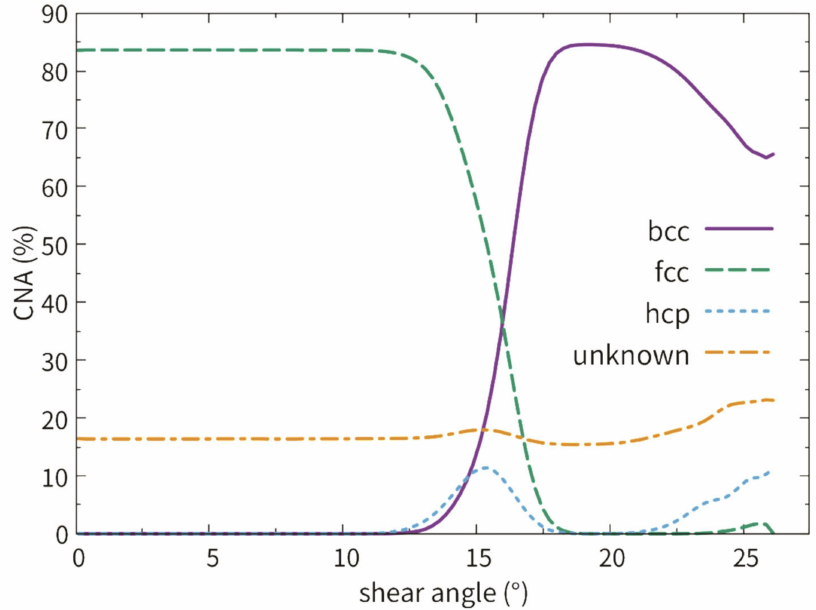
Figure 7. Fractional phase contents of film 2 with (110) fcc free surface as a function of shear angle at a temperature of 300